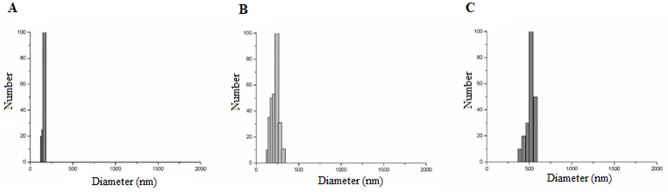
Particle size distribution by laser diffraction of encapsulated powder particles obtained by O/W emulsification technique.(A) OG: Quinoa oil and porcine gelatin in aqueous phase 2; (B) OWG1: Quinoa oil, whey protein isolate and porcine gelatin in aqueous phase 2; (C) OWG2: Quinoa oil, whey protein isolate in aqueous phase 1, and porcine gelatin in aqueous phase 2.